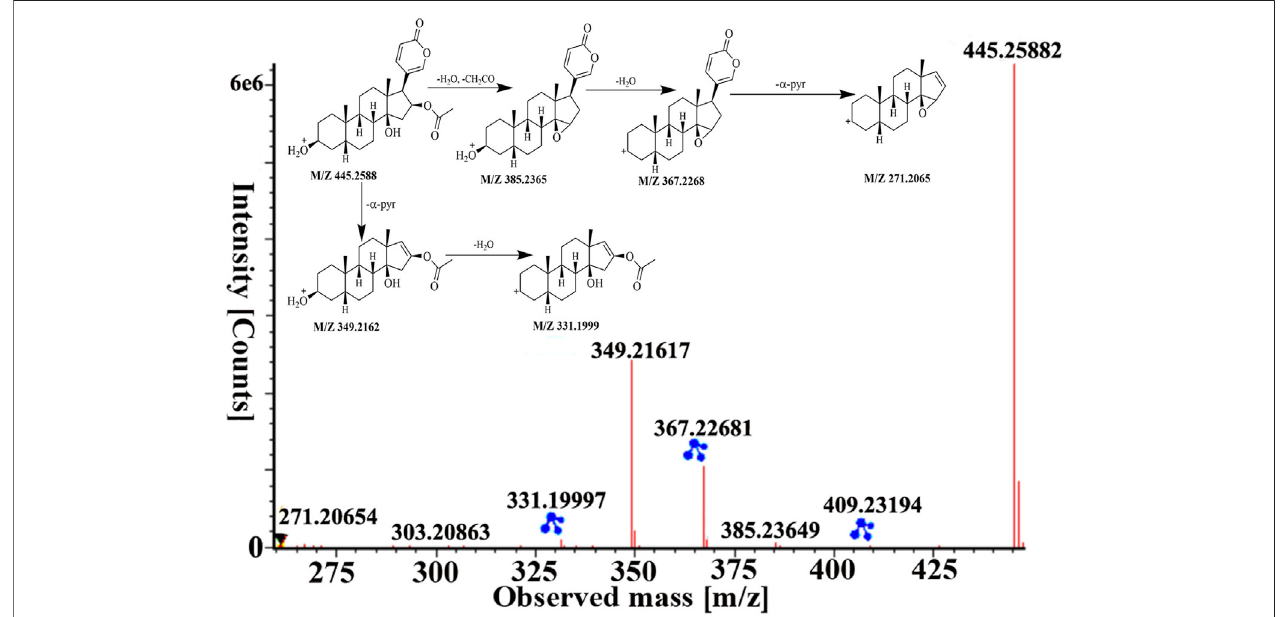
FIGURE 5 | The MS spectra and fragmentation pathway of bufotalin in positive ion mode.